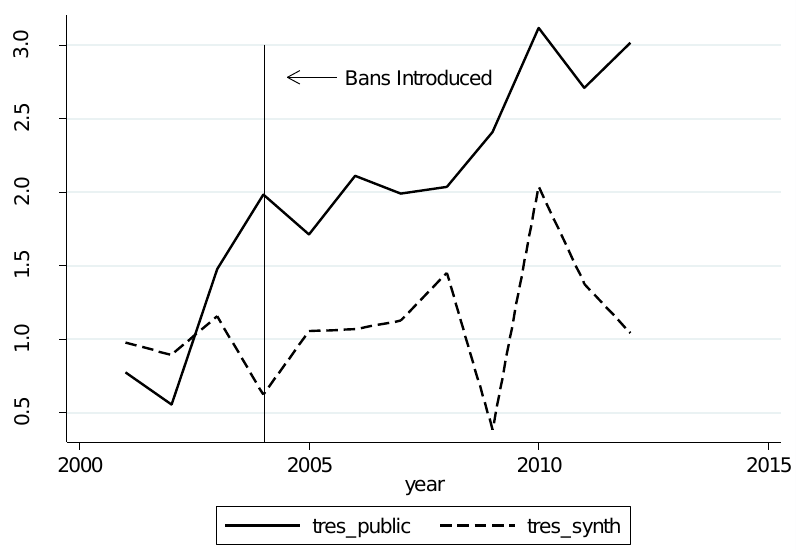
Figure A3. Trends in trespass arrests: public housing vs. synthetic public housing.